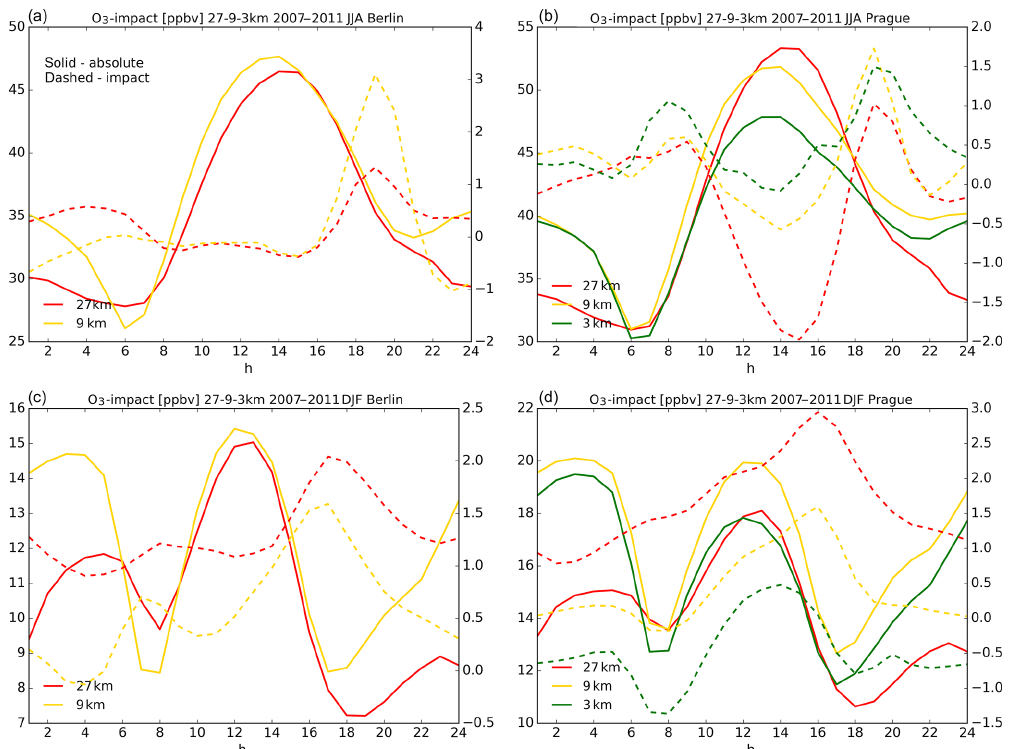
Figure 29. The diurnal cycle of the absolute ozone concentrations (solid; left-hand axis) as well as the total-impact (i.e., the t+q+uv+kv- impact; dashed; right-hand axis) above Berlin (a, c) and Prague (b, d) for JJA (a, b) and DJF (c, d) in ppbv. Red, orange and green colors stand for 27, 9 and 3km resolutions,